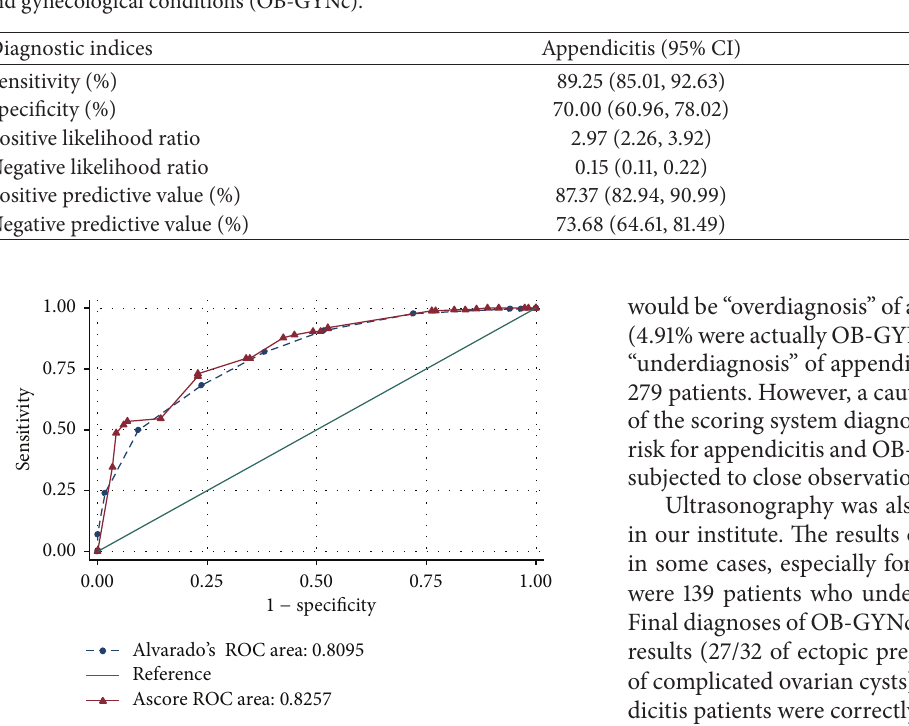
Figure 2: Receiver operating characteristic (ROC) curves of Alvarado’s score (dash line) and appendicitis score (ascore, solid line) for diagnosis of